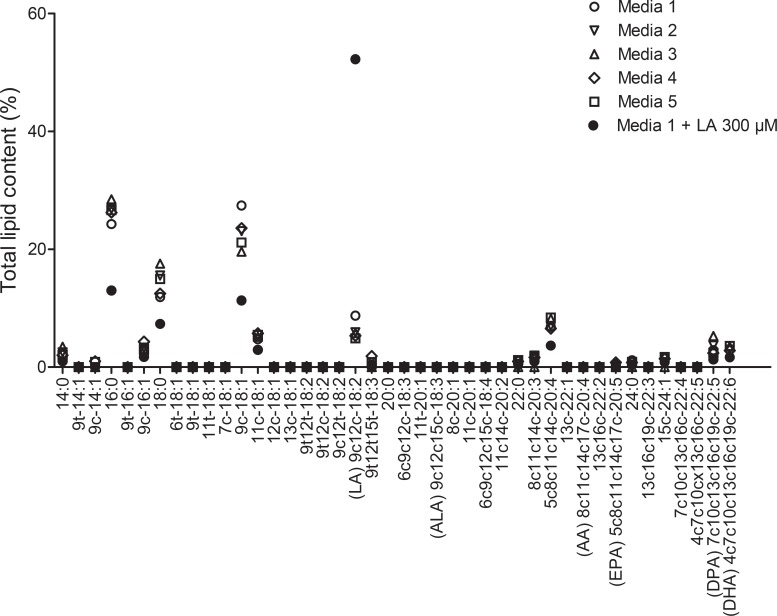
Evaluation of the lipid content in serum-supplemented culture media used for tissue reconstruction.Media 1 to 5 differ by the FCS lot used. Media + 300 μM LA (9c12c-18:2) contains the same FCS as media 1. Absolute mean value of 9c12c-18:2 in the 5 unsupplemented media was 2.13 μg/ml. A concentration of 56.0 μg/ml was detected in media 1 supplemented with linoleic acid at a concentration of 84.1 μg/ml. This media was used for tissue reconstruction with supplementation at the optimal concentration for culture (150 μM).